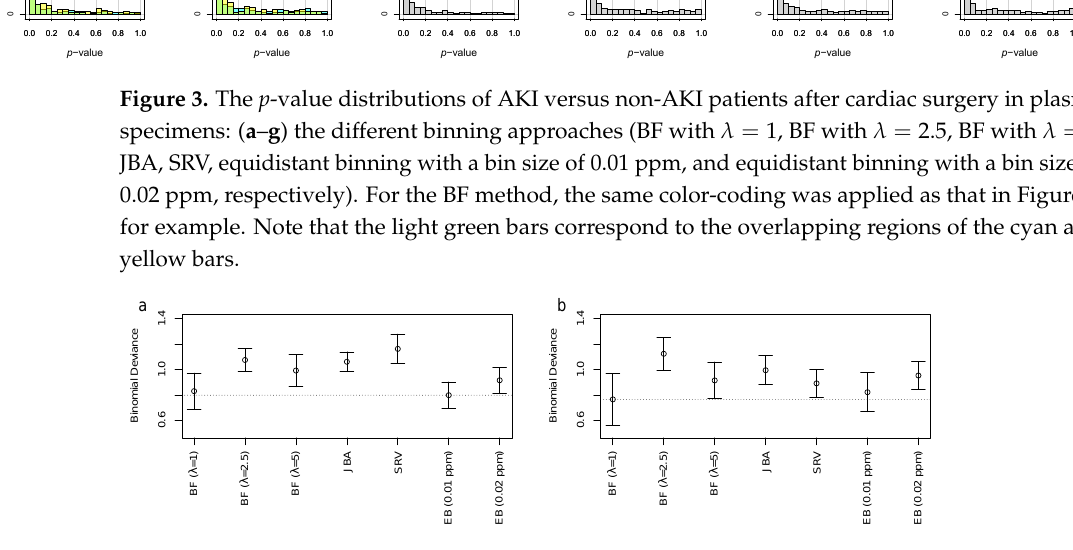
Figure 4. The binomial deviances ( y -axis) from the leave-one-out cross-validation using the different binning approaches ( x -axis) for the plasma ( a ) and urinary ( b ) AKI data. The dotted horizontal lines correspond to the best method for the plasma (EB (0.01 ppm)) and urine (BF ( λ = 1)) data. The error bars correspond to ± 1 standard deviation.